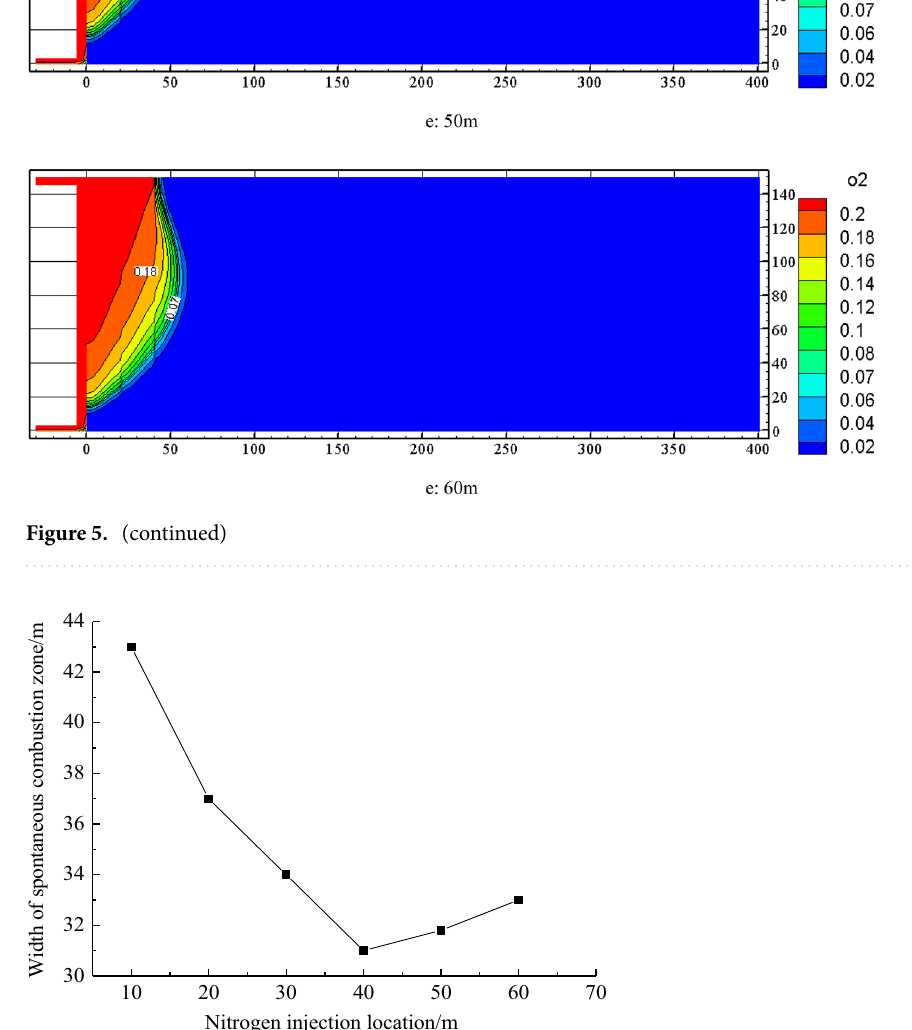
Figure 6. Goaf spontaneous combustion zone width with injection nitrogen location